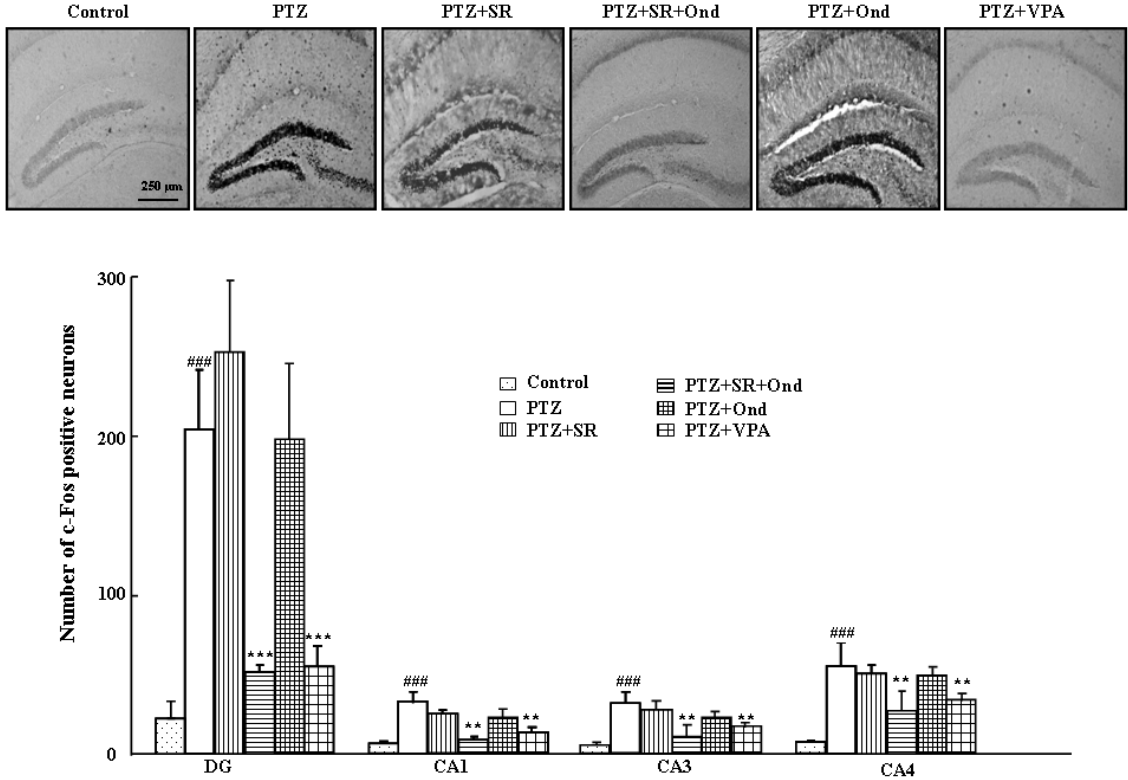
Figure 3. Effects of ondansetron and SR 57227 on c-Fos expression in hippocampus. PTZ: pentylenetetrazole (65 mg/kg, i.p.); SR 57227: 10 mg/kg, i.p; Ond: ondansetron (0.2 mg/kg, i.p.); VPA: sodium valproate (400 mg/kg, p.o.). DG: dentate gyrus; Columns represent the mean 6 S.E.M.